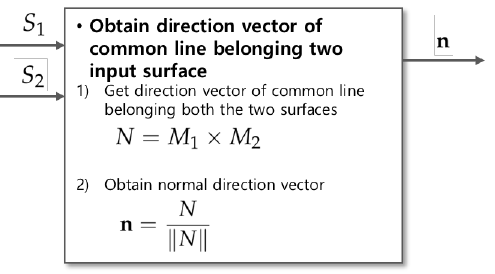
Figure A4. Obtaining the direction vector of the common line belonging to the two given